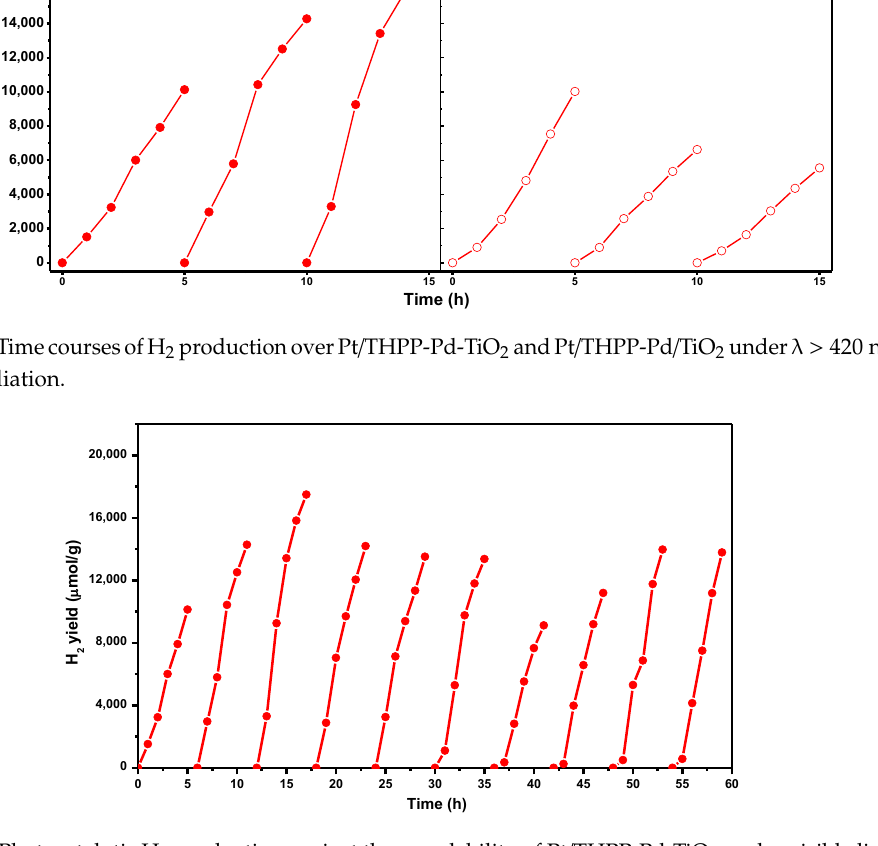
Figure 9. Photocatalytic H 2 production against the recyclability of Pt/THPP-Pd-TiO 2 under visible light irradiation (λ > 420 nm) in 100 mL H 2 O/TEOA (9: 1 v/v).